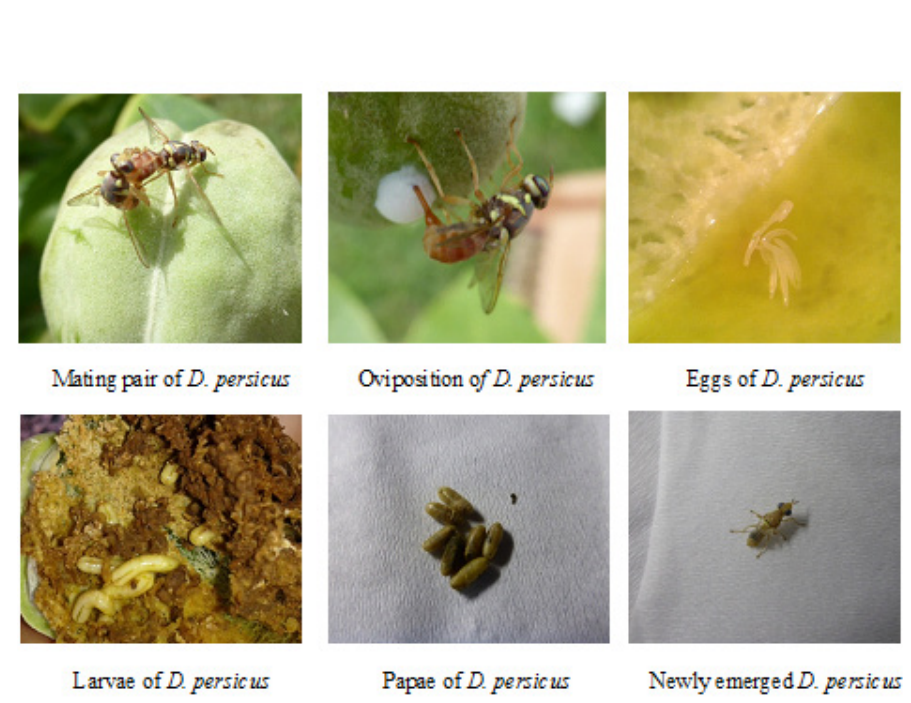
Figure 4: Life cycle stages of Dacus persicus .